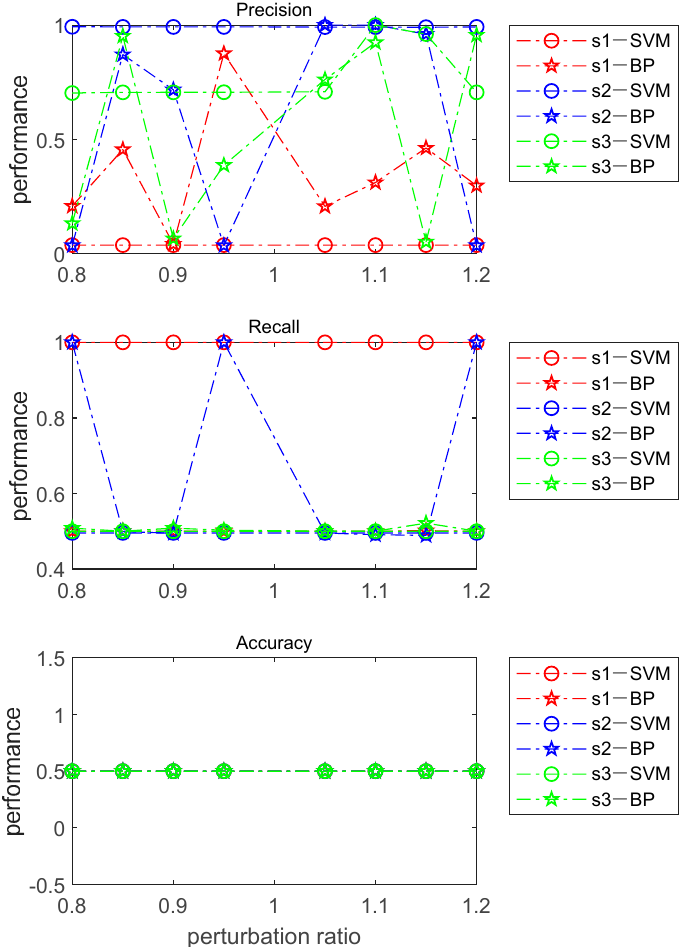
Figure 10. Fluctuations in the three index values when the disturbance ratio changes from 0.8 to